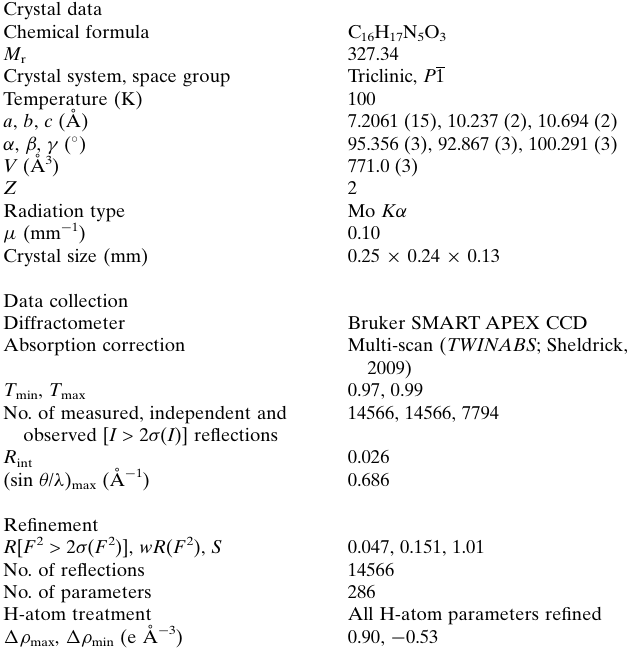
Table 3 Experimental details. Crystal data Chemical